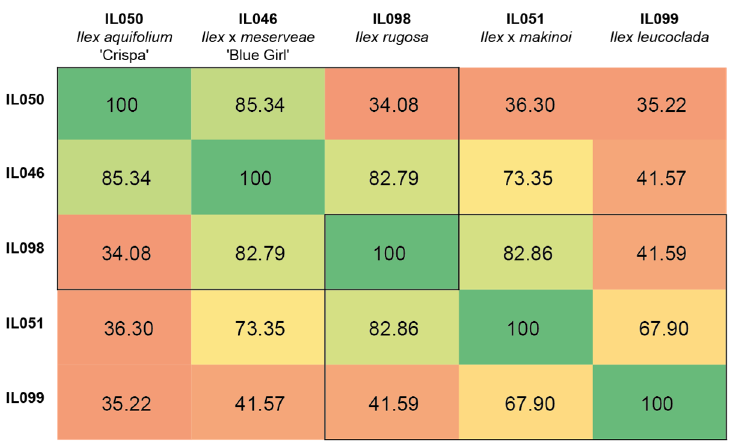
Figure 4. Parental relations of hybrids I . x meserveae (IL046) ( I. aquifolium x I. rugosa ) and I . x makinoi (IL051) ( I . leucoclada x I . rugosa ). The high allele similarity of GBS fingerprints reflects the relationship of I. x meserveae (IL046) to I. aquifolium ‘Crispa’ (IL050) (85.34%) and I. rugosa (IL098) (82.79%), whereas I. aquifolium ‘Crispa’ and I. rugosa have an allele similarity of only 34.08%. Similarly, the relation of I. x makinoi (IL051) to I. leucoclada (IL099) and I. rugosa (IL098) can be derived from their high allele similarities of 82.86% and 67.90%, respectively, whereas I. leucoclada and I. rugosa have a much lower allele similarity of 41.59%.